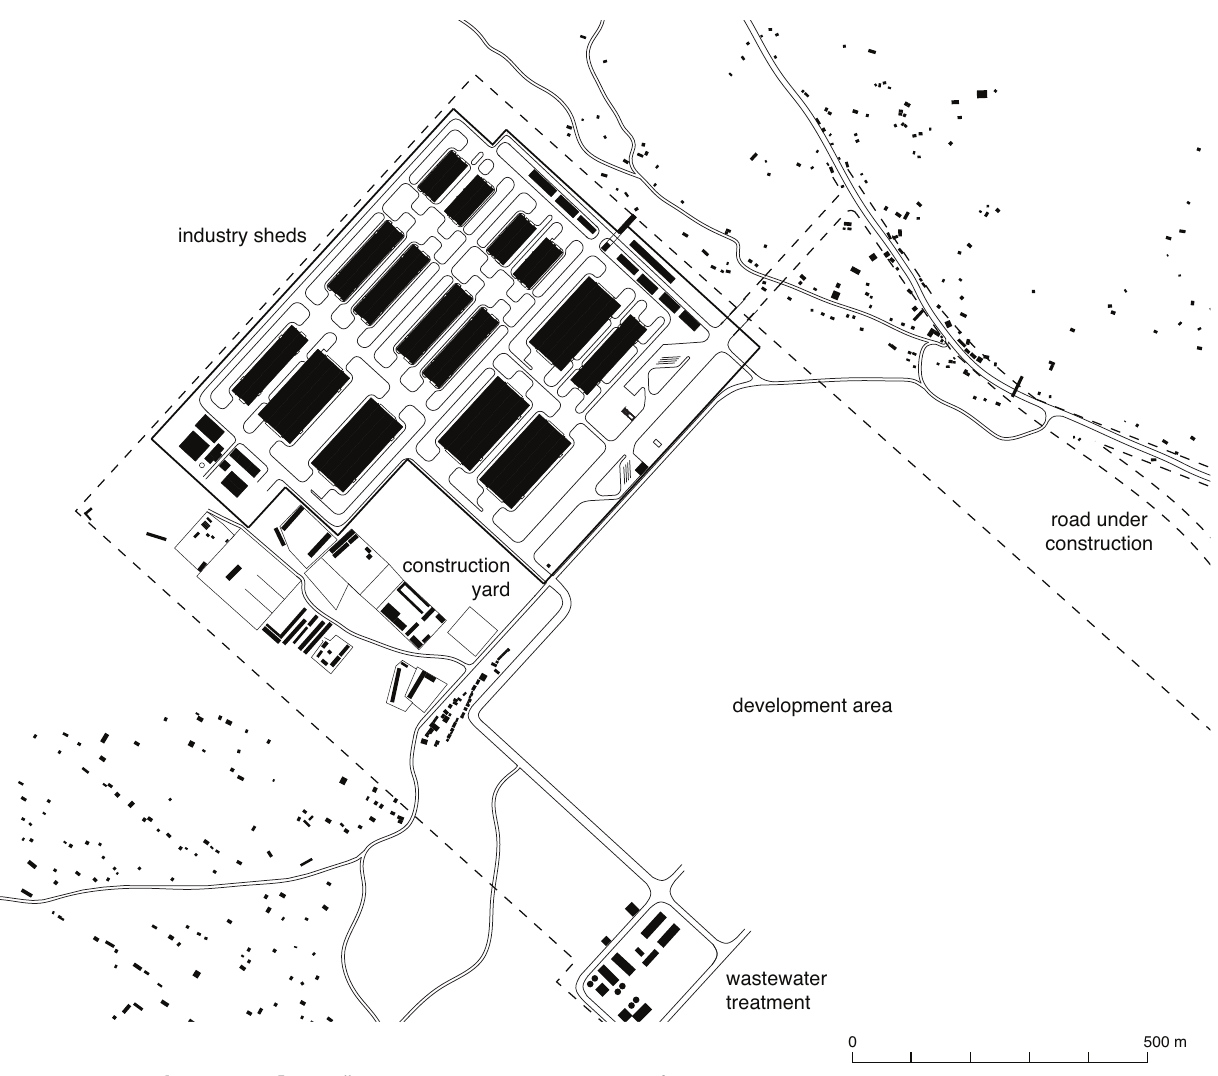
Figure 3. MIP, first construction phase (2018). Sources: Authors based on Google Maps, OpenStreetMap, IPDC (2015), and authors’